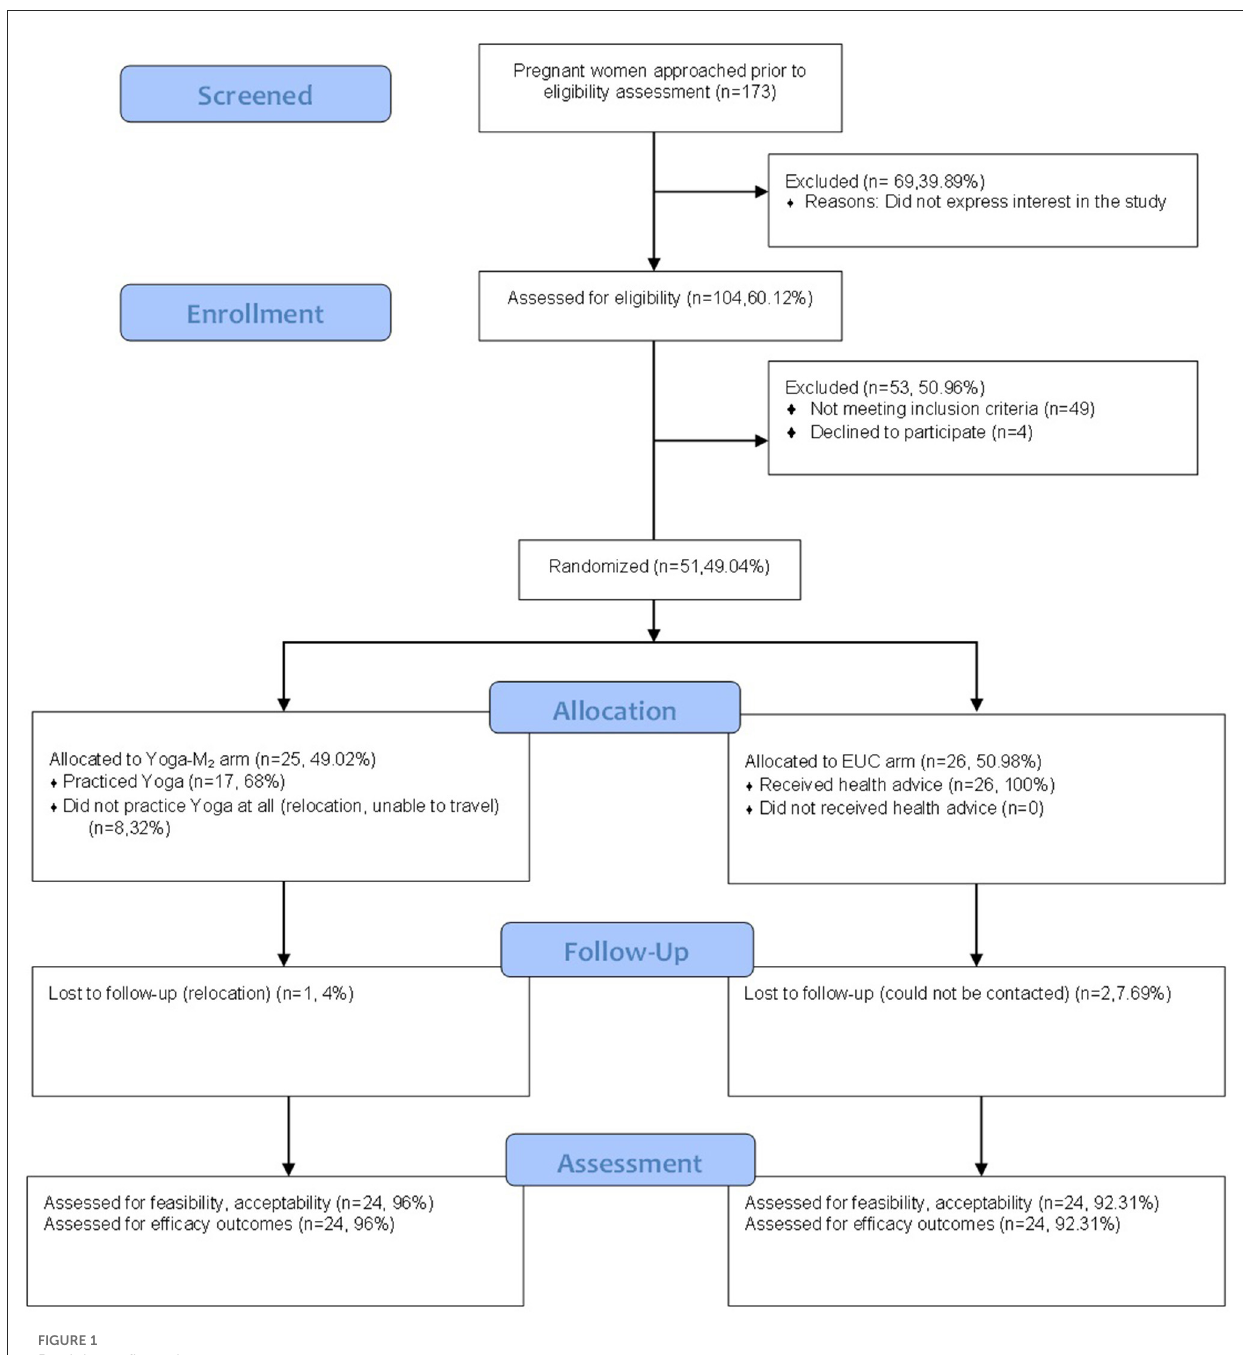
FIGURE1 Participant flow